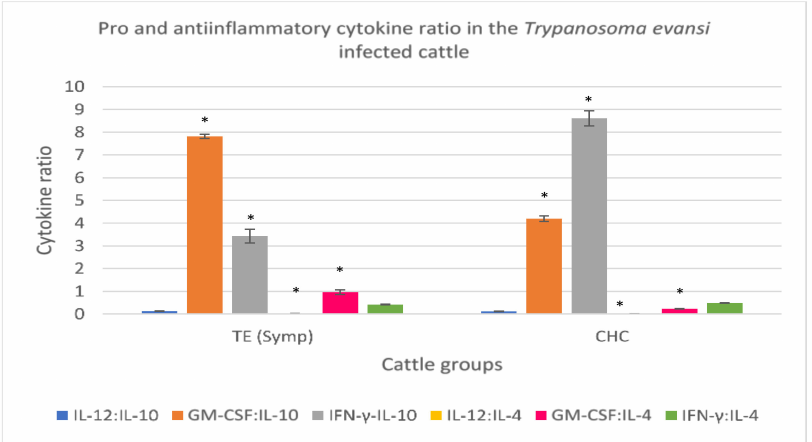
Figure 5. Pro- and anti-inflammatory cytokine ratio in symptomatic cattle naturally infected with Table 1. 2 VSG gene. High serum GM-CSF:IL-10 and GM-CSF:IL-10 ratios, and low IL-12:IL-10 and IFN- γ :IL-10 ratio were prominent findings in the Trypanosoma evansi infected cattle. CHC: Clinically healthy cattle (control). IL-12: Interleukin 12; IL-10: Interleukin 10; GM-CSF: Granulocyte Macrophage-colony stimulating factor; IFN- γ : Interferon gamma; IL-4: Interleukin 4. * Asterisk superscript on a parameter indicates significant difference p <